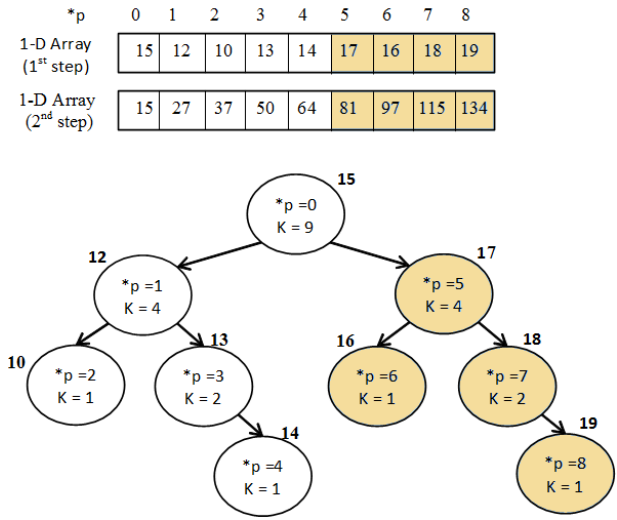
Figure 7. Example of “Integral Binary